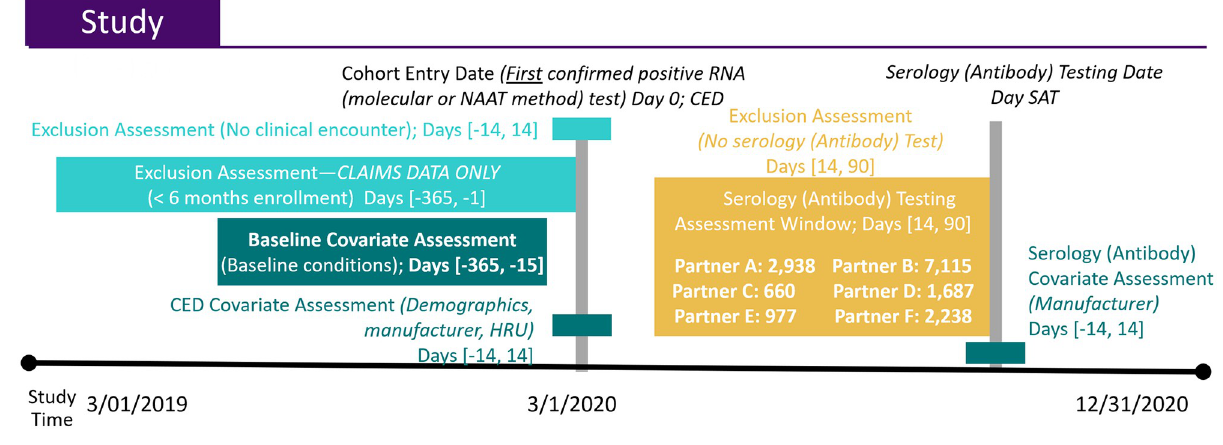
Fig 2. Study design